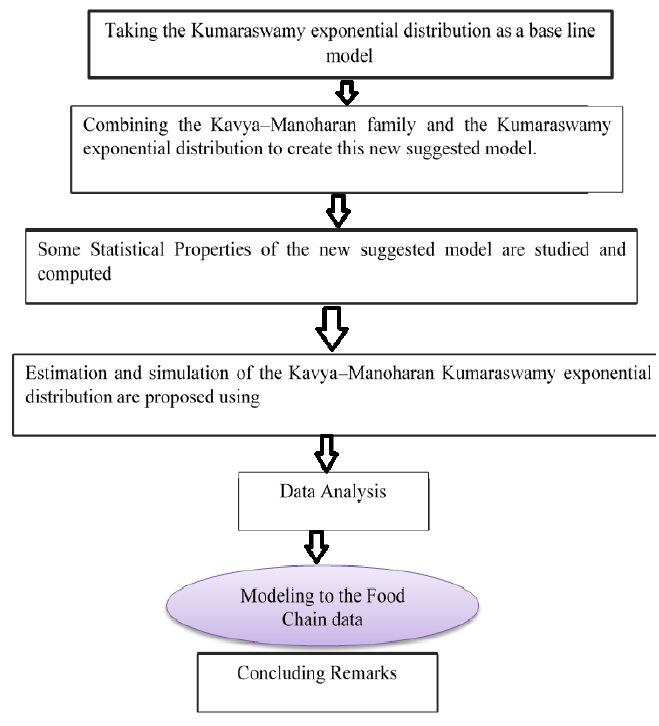
Figure 1. A detailed graphic representation of the